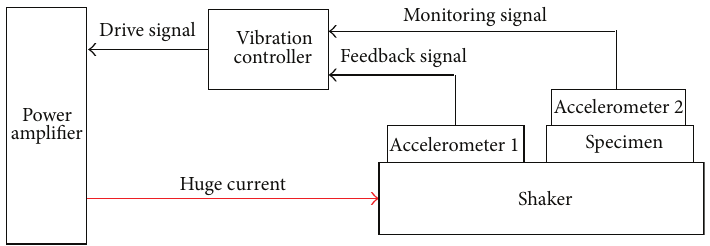
Figure 1: Closed-loop vibration fatigue test system configuration.